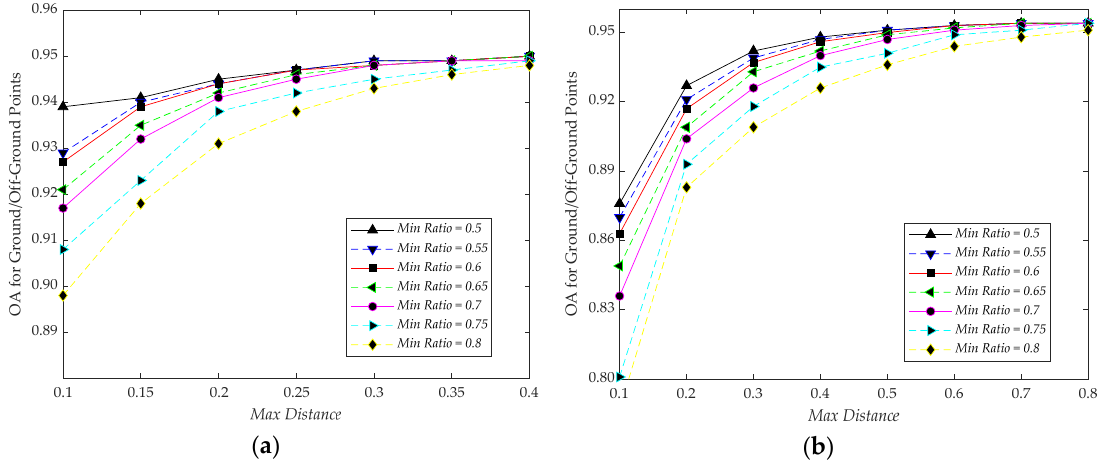
Figure 14. ( a ) Thresholds analysis for RANdom SAmple Consensus (RANSAC) algorithm on Vaihingen Dataset; ( b ) thresholds analysis for RANSAC algorithm on GML Dataset A.